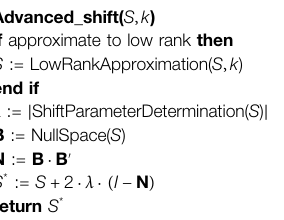
Algorithm 1 Advanced shift eigenvalue